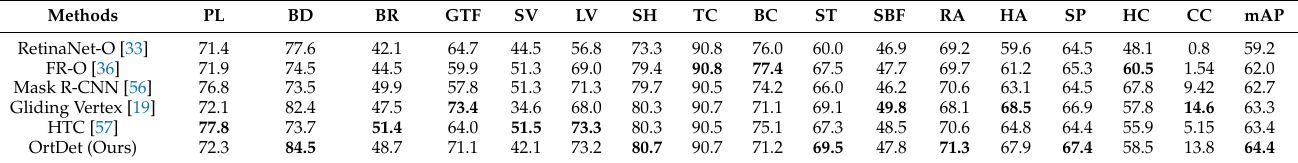
Table 2. Mean average precision (%) of the different methods for the DOTA-v1.5 dataset. Methods mAP RetinaNet-O [33]